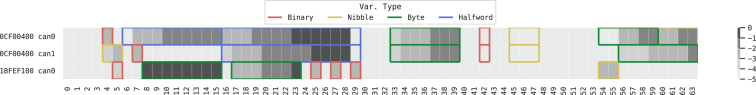
Bitflips magnitude heatmap for vehicle T-1, limited to the ECU identifier that carries the information regarding the (RPM) and speed sensors.